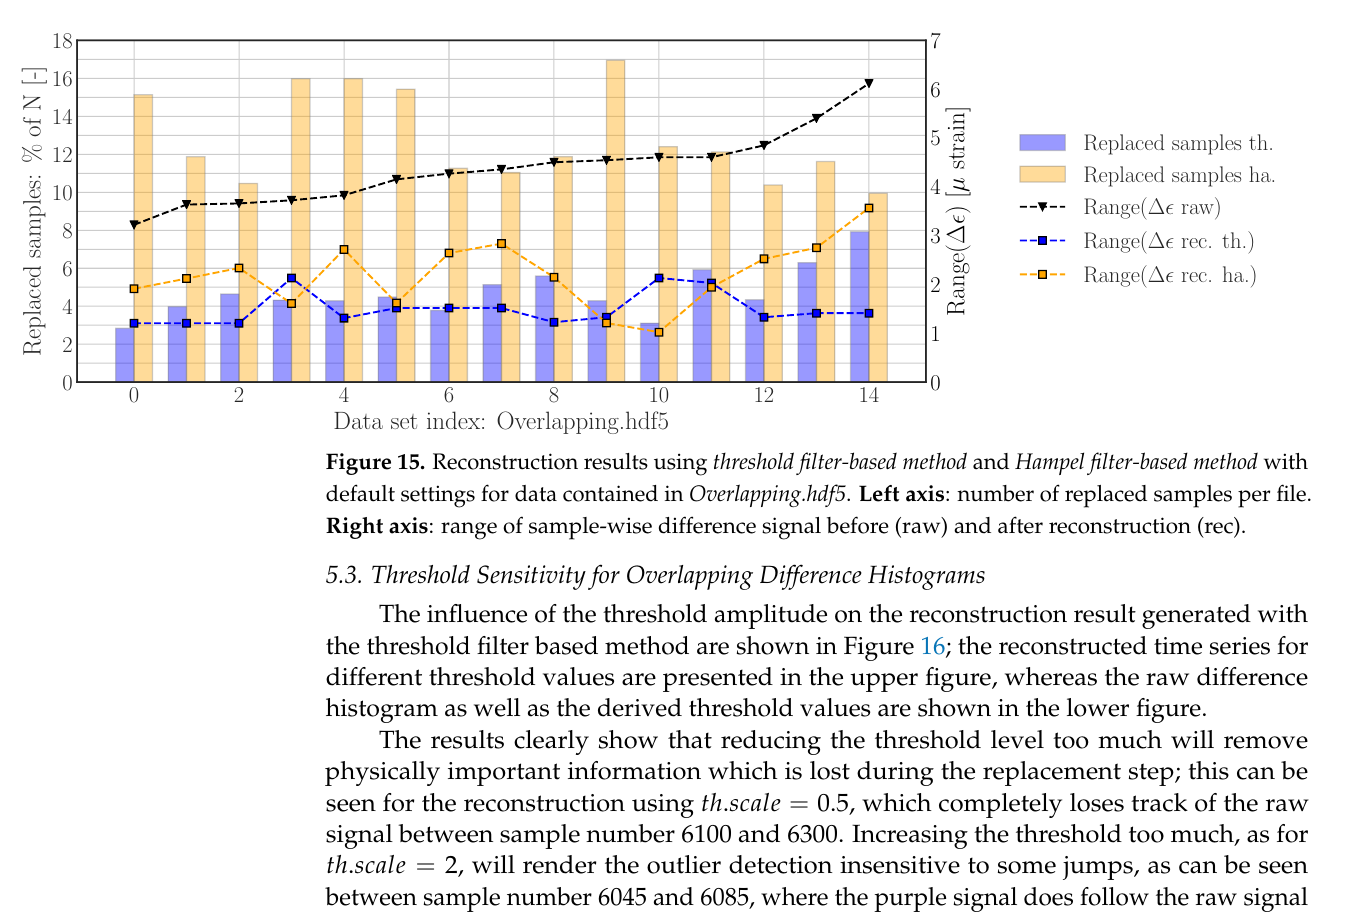
Figure 14. Left : Reconstruction results as presented in Figure 13 without applying a median filter on the segment wise threshold levels. Right : The last 25 samples contain more than 12 outliers, effectively resulting in a threshold level which will be leave all outliers undetected—as indicated by the red annotations.